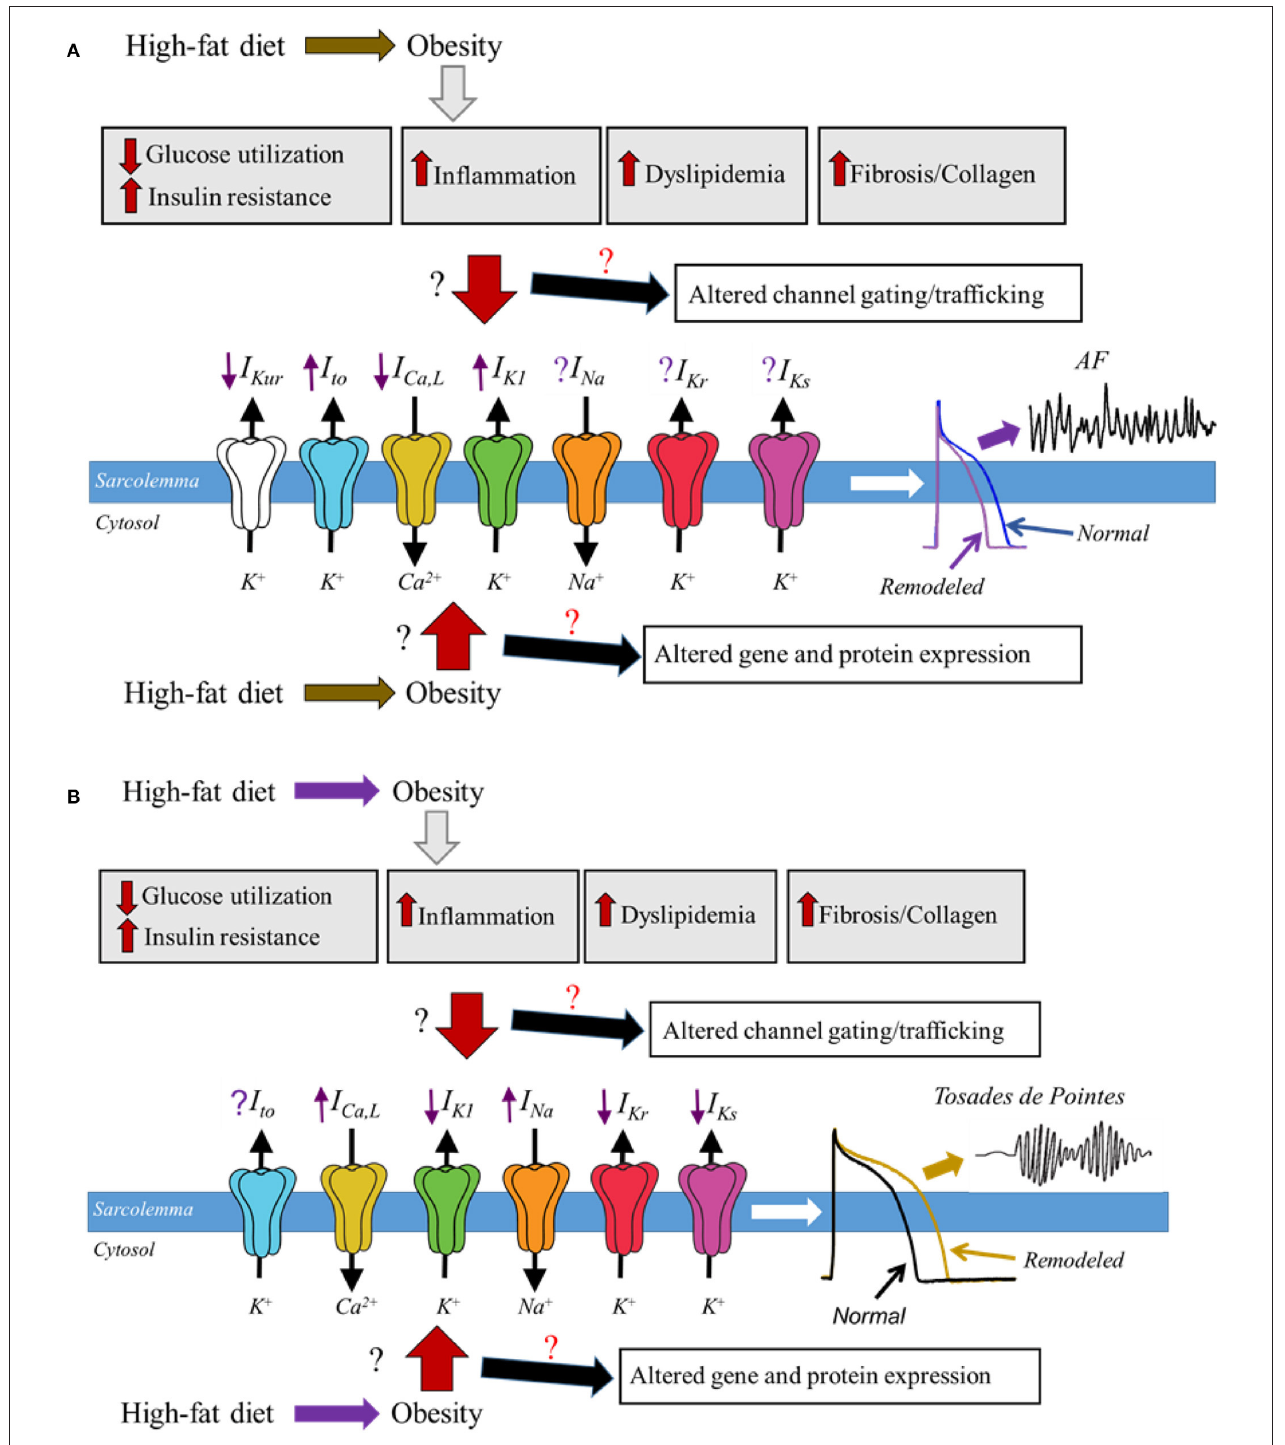
FIGURE 1 | Schematic representation of potential molecular mechanisms of obesity and ion channel remodeling process that may underlie cardiomyopathies of obesity. In diet induced obesity, the associated enlarged adipose tissue leads to altered glucose utilization and insulin resistance, increased levels of proinflammatory cytokines, dyslipidemia, fibrosis, and increased accumulation of collagen; all of which are likely to play a pivotal role in remodeling of major atrial and ventricular ion channels leading to either a faster (A) or delayed (B) , repolarization and predispose obese patients to respectively AF and Torsades de Pointes . How and whether obesity molecular mechanisms alter the functional expression of cardiac ion channels is poorly understood, and we have denoted this lack of clarity in this cartoon as